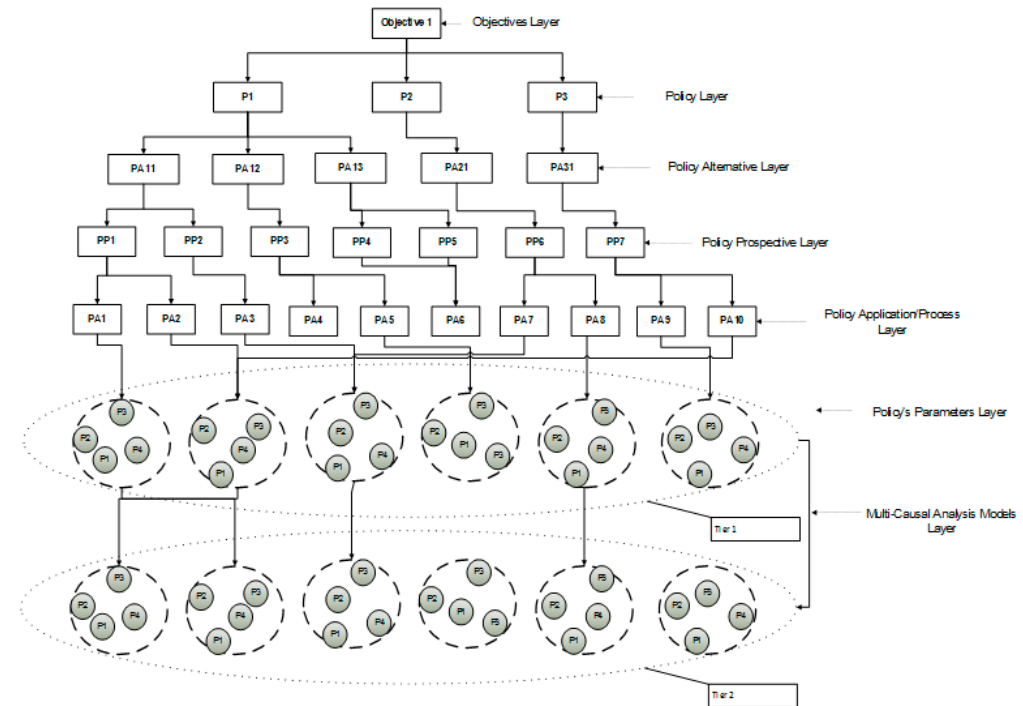
Figure A5. The generic computational regulatory policy change governance model.